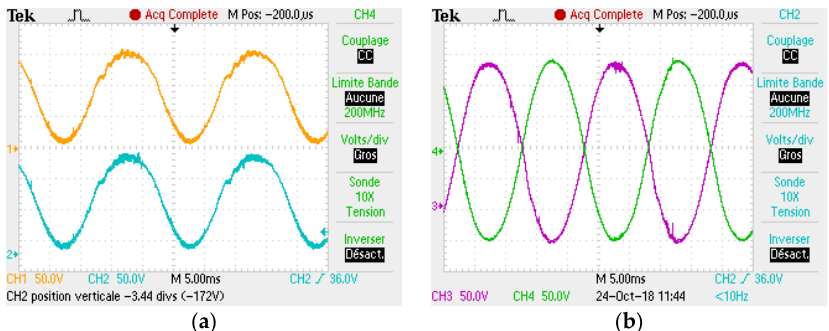
Figure 11. Input voltage at 90 V and load at 30 Ω. Experimental waveforms of ( a ) V c1 (CH1: Time (5 ms/div), V c1 (50 V/div)) and V c2 (CH2: Time (5 ms/div), V c2 (50 V/div)); ( b ) V c3 (CH3: Time (5 ms/div), V c3 (50 V/div)) and V c0 (CH4: Time (5 ms/div), V c0 (50 V/div)).